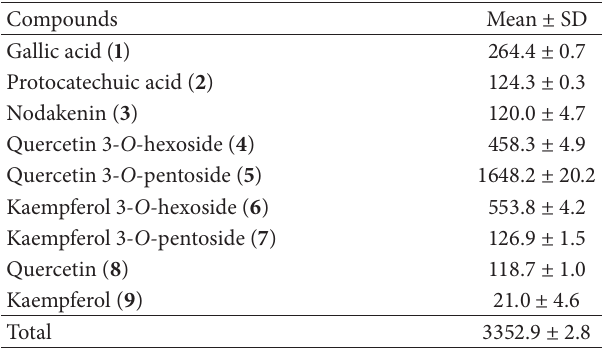
Table 3: Concentration of polyphenols in Euphorbia supina (mg/kg fresh